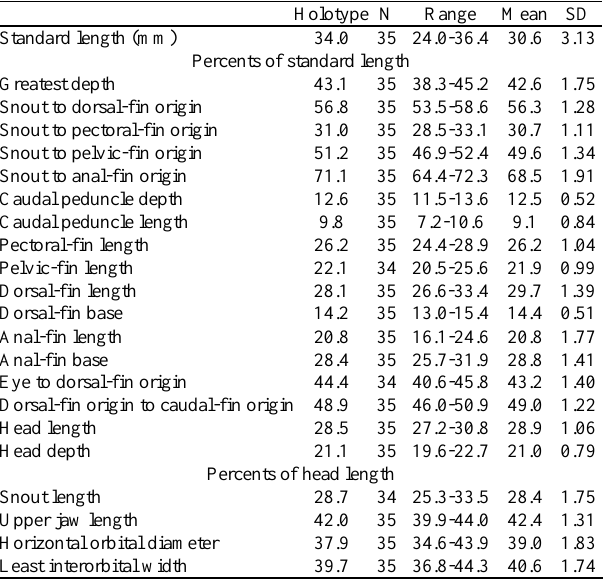
Table 1. Morphometric data of Moenkhausia forestii , holotype and